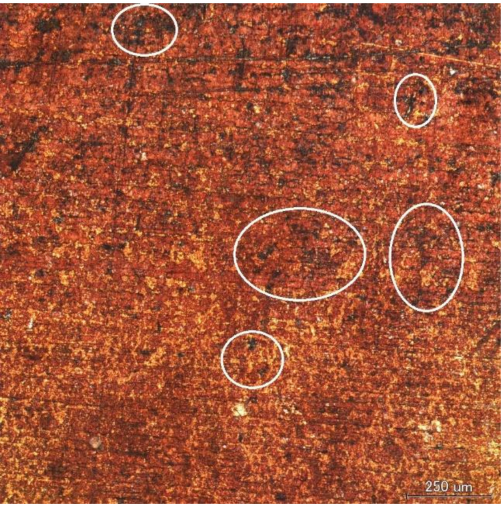
Figure 2. Surface observations of Cu tube specimen immersed in 10 3 ppm Cu(HCOO) 2 after 10 days